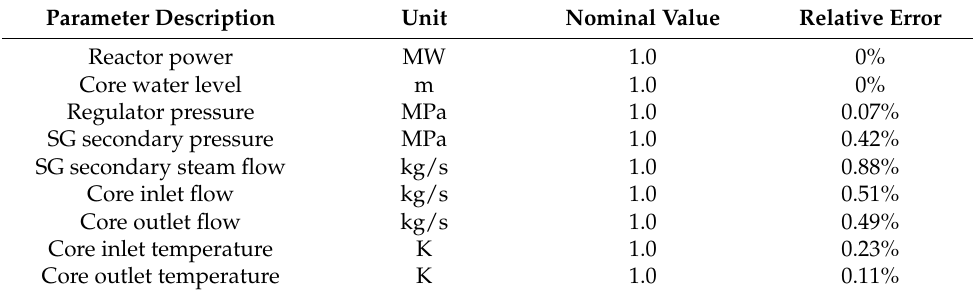
Table 1. Comparison between calculated value and design value.